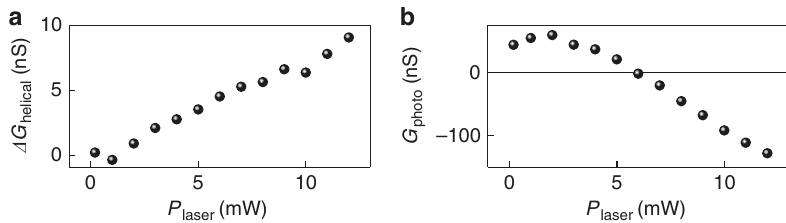
Fig. 2 Irradiance dependence of helical and polarization-independent photoconductance. a The helical Δ G helical is linear up to the largest laser powers investigated, and can be tuned to be positive or negative. The polarity depends on the excitation position and the direction of the dark current in the platelets. We show Δ G helical for a right edge of a BTS platelet at a positive bias V sd = + 0.55 V. b The polarization-independent photoconductance G photo of the BTS platelets shows a non-linear power dependence. The non-linearity is an interplay of saturating photoconductance contributions of the surface and bulk states of the BTS platelet (saturating for P laser ≥ 5 mW) and a negative bolometric photoconductance dominating at large laser powers [cf. ref. 12 ]. All measurements are performed at room temperature as the spin polarization S at the left and right edges of the BTS platelet. As apparent from Fig. 3c to h, a fi nite G helical is observed only at a fi nite bias voltage, thereby excluding G helical as a pho- tocurrent effect which would have a fi nite magnitude at zero bias. We note that for V sd = 0 (Figs. 3d and 3g), the originally detected signal I helical ~ 0 nA is plotted instead of G helical , as an experi- mental conductance is not de fi ned at zero bias. As another rele- vant observation, G helical fl ips by π when either the bias V sd is reversed (cf. Fig. 3c vs. 3e and Fig. 3f vs. 3 h), or when the laser spot position is exchanged between the left and right platelet edge.